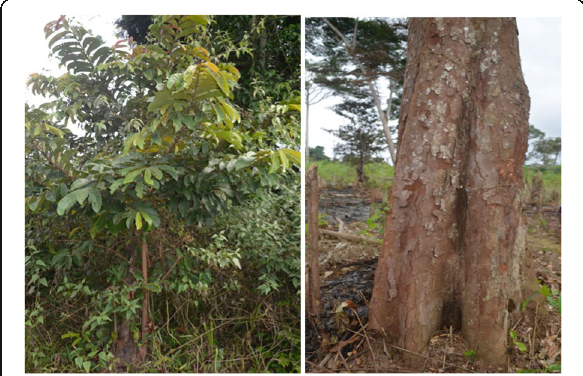
Fig. 1 Shrub and trunk of S. ochocoa. Photos taken at Mitzic, Woleu-Ntem (Northern of Gabon) by Ngoua-Meye-Misso with digital camera Cannon 16 M pixel made in